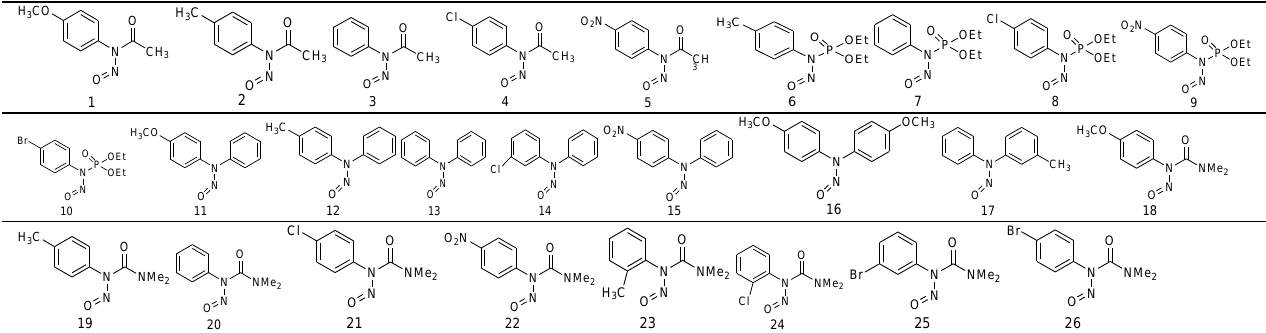
Table 1. The structures of the 92 organic carrier molecules with Y-NO a